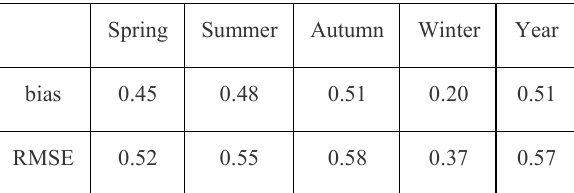
Table 2. PWV bias and RMSE changes (cm)